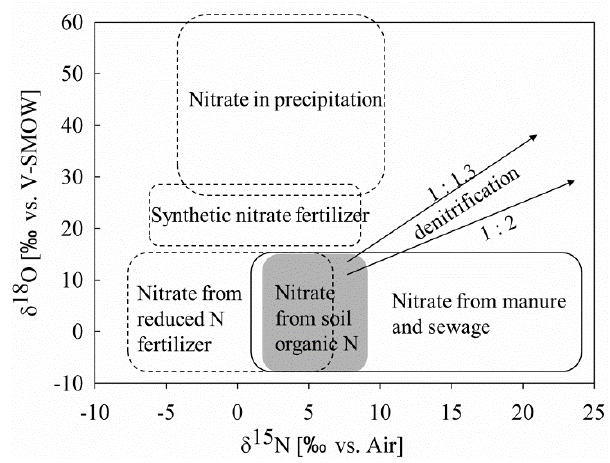
Figure 1. Distribution of δ 15 N and δ 18 O from different potential nitrate sources